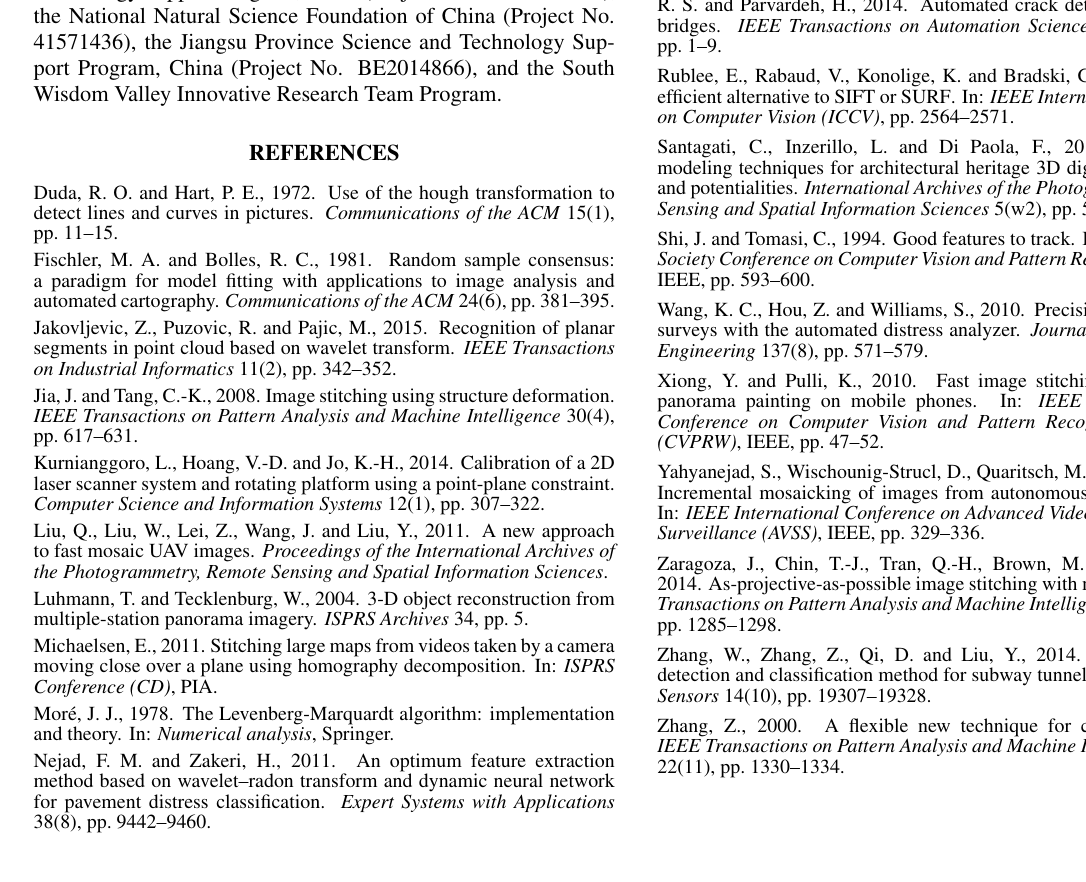
(c) Stitched panorama with the optimized (cid:2)(cid:2)(cid:2) via combining image feature points and structure lines